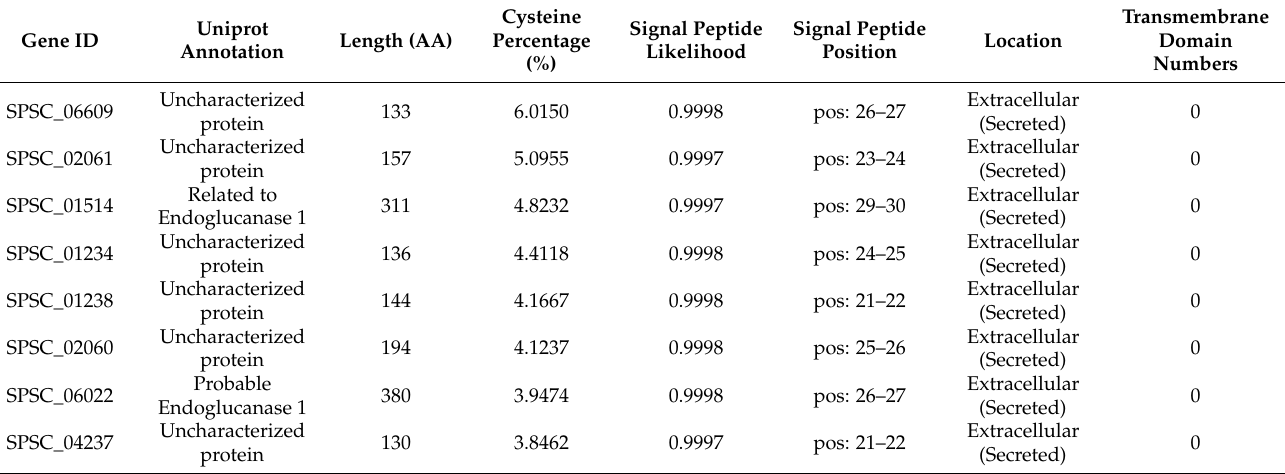
Figure 7. Small cysteine-rich proteins (SCRPs) in the MEpurple and MEdarkturquoise modules. ( A ) In 275 proteins from two modules, 86 had signal peptides, 23 had >3% cysteine content, and 118 had no transmembrane domain. A total of 21 proteins exhibited all these characteristics and were considered SCRPs. ( B ) Expression profiles of the predicted SCRP candidate effectors. The RPKM were standardized by rows into fractions (0 to 1) for better visualization. The red arrows indicate hub genes identified by the Cytohubba plugin. Table 3. Prediction of candidate effectors in S. scitamineum